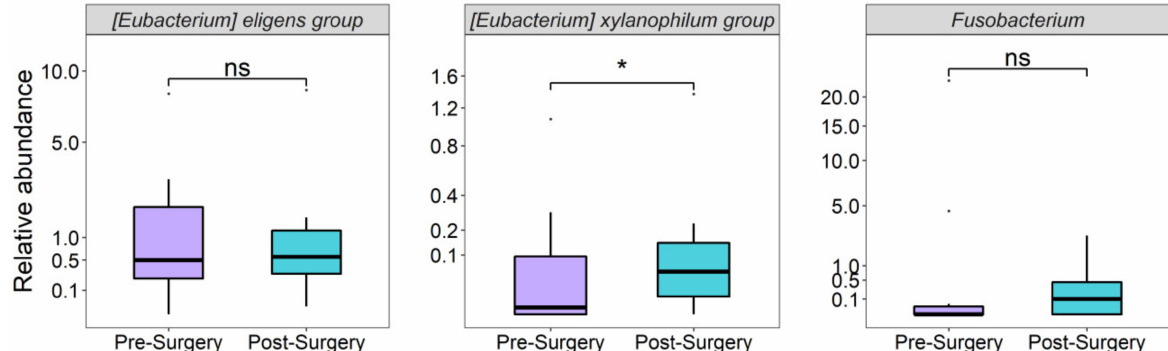
Figure 8. Relative abundance of [Eubacterium] eligens group , [Eubacterium] xylanophilum group and Fusobacterium in patients with AD before and after bariatric surgery. * p < 0.05, ns; not